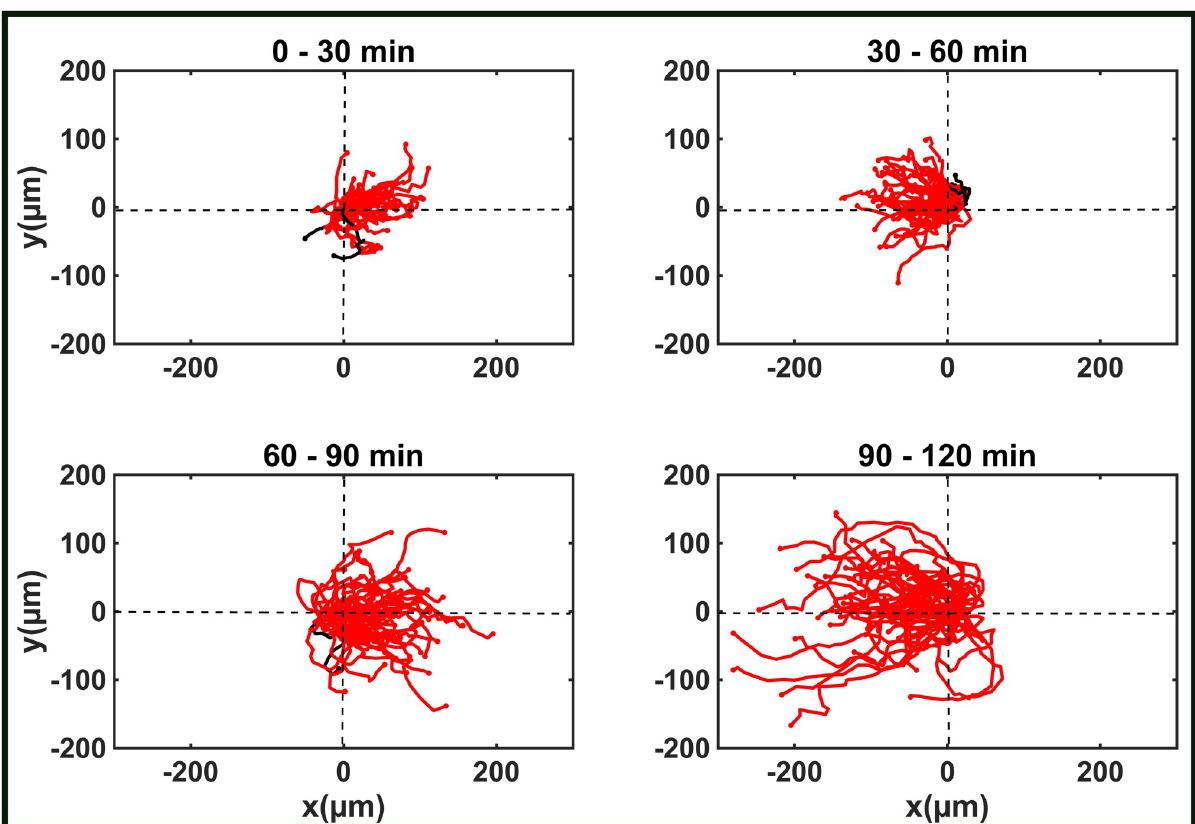
Fig 2. Cell tracking diagrams of fully developed AX2 cells. The length of the migration paths increases significantly over time. In each experiment at least 45 cells were analysed. The diagrams refer to cells that were starved for 5 hours. They originated from at least three different experiments.